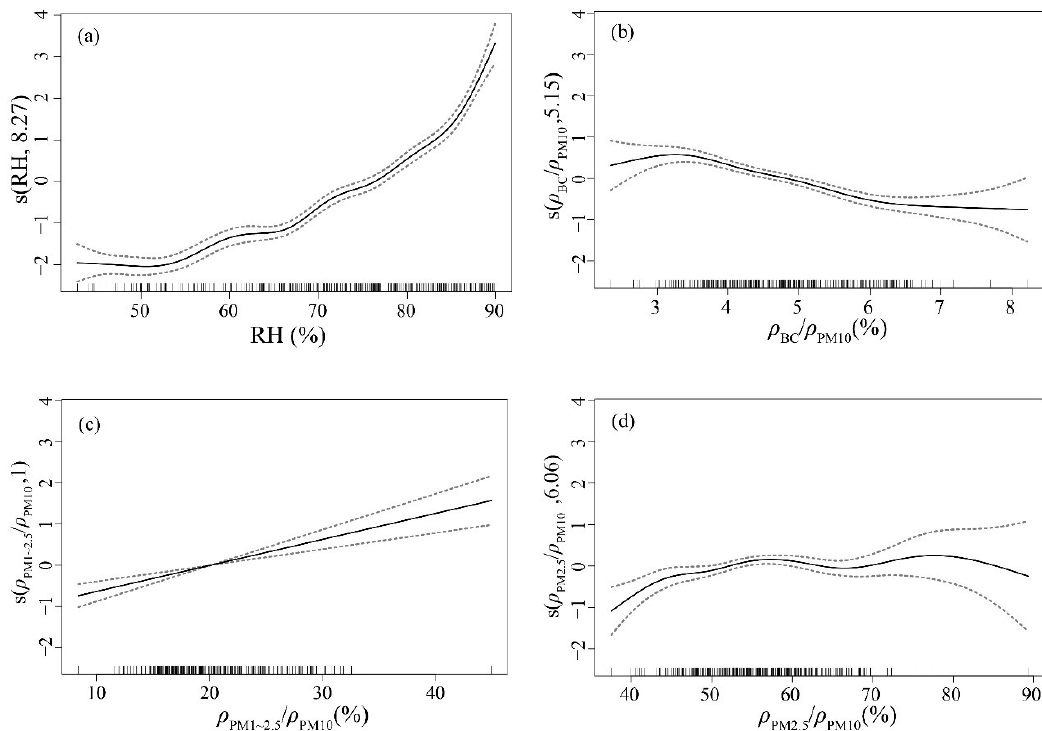
Figure 8. At PM 2.5 pollution concentration, the effects of the environmental meteorological factors on the change of the aerosol extinction coefficient per unit of mass. ( a – d ) represent the effects of RH, ρ BC / ρ PM10 , ρ PM1~2.5 / ρ PM2.5 and ρ PM2.5 / ρ PM10 , respectively.